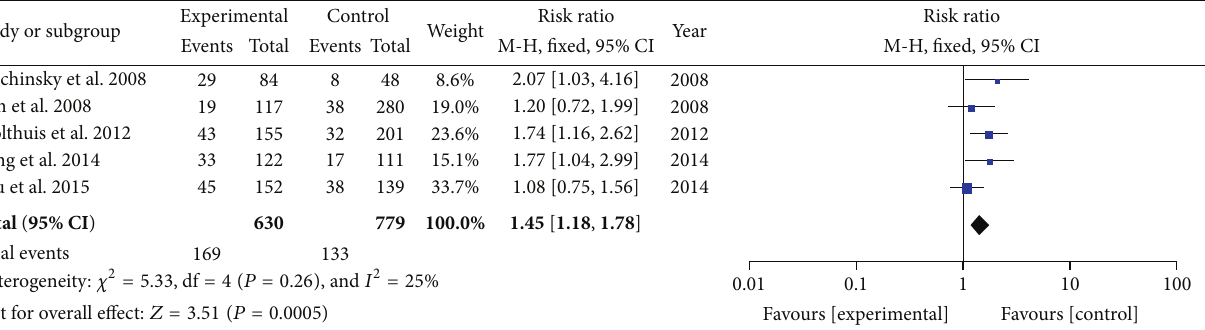
Study or subgroup